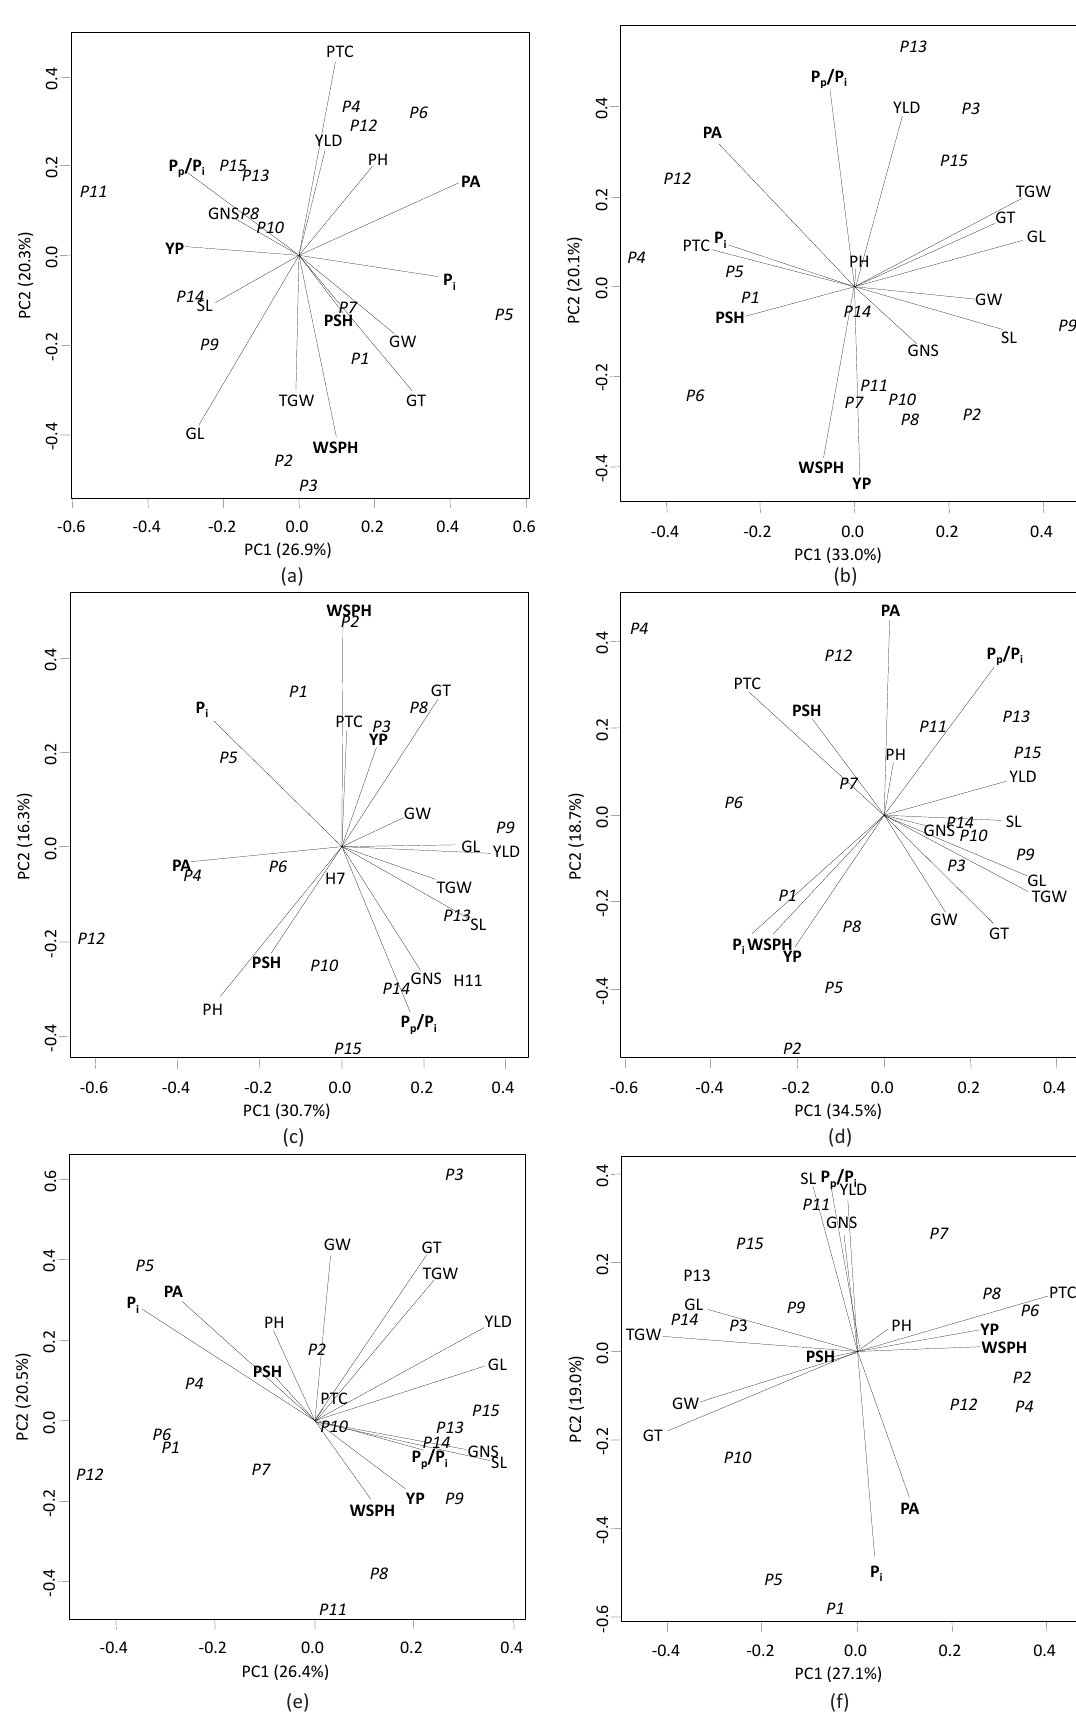
= inorganic phosphorus; P /P = phytic i p i